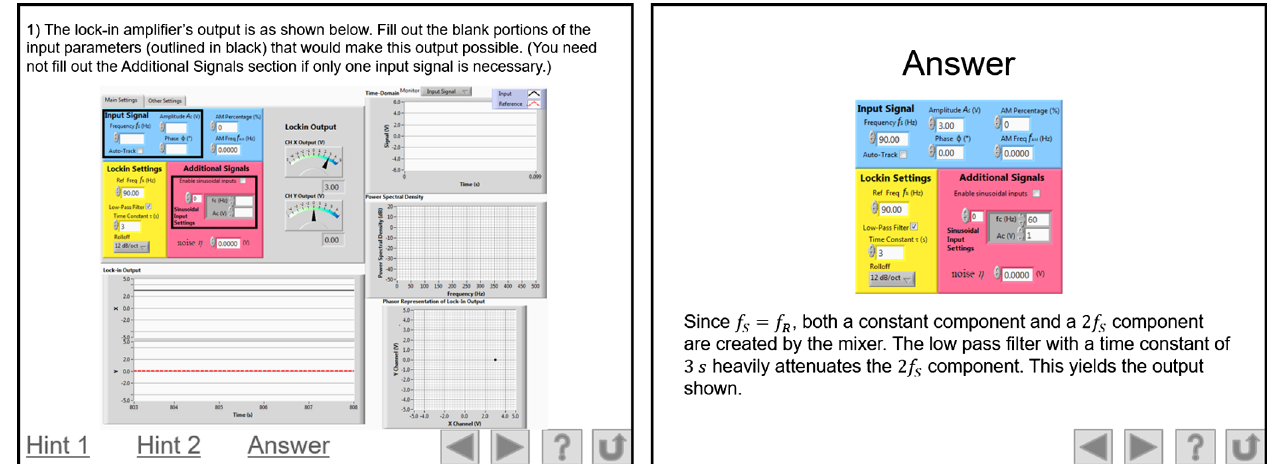
FIG. 3. An example of one of the tutorial questions which asks students to predict the input signal characteristics (left) and the answer to that question